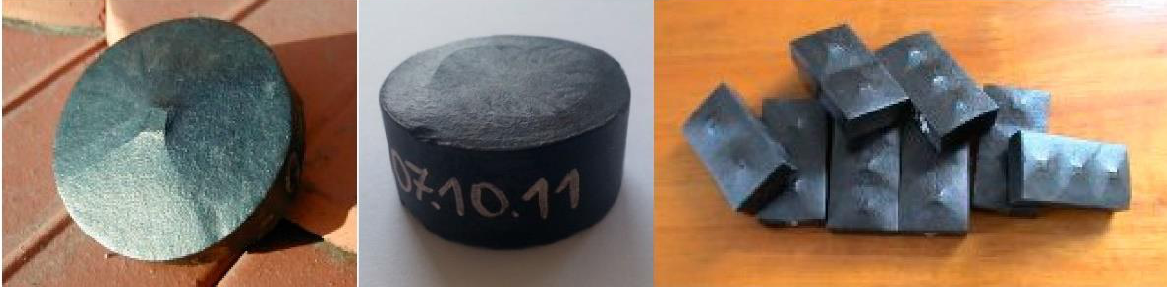
Figure 1. Mono crystal high-temperature superconducting (HTS) bulks from ATZ company.